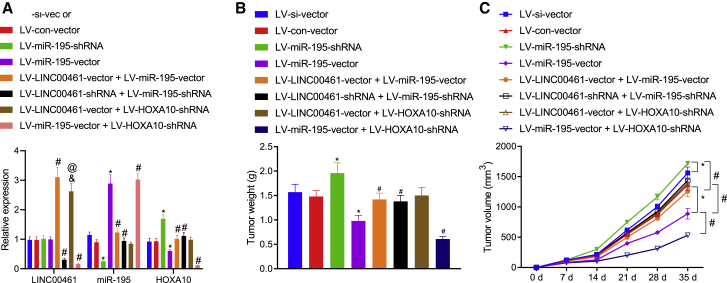
Tumorigenesis in mice is enhanced by LINC00461 by blocking miR-195-mediated inhibition of HOXA10(A) The expression of LINC00461, miR-195, and HOXA10. (B) Tumor weight in nude mice. (C) Tumor volume in nude mice. All of the data were measurement data expressed as means ± standard deviations. The data among multiple groups were compared using 1-way ANOVA or repeated-measures ANOVA. n = 7 for BALB/c-nu mice following each treatment per experimental xenograft. ∗p < 0.05 versus the LV-si-vector or LV-con-vector group. #p < 0.05 versus the LV-miR-195-shRNA or LV-miR-195-vector group. &p < 0.05 versus LV-LINC00461-vector + LV-miR-195-vector group. @p < 0.05 versus the LV-LINC00461-vector + LV-miR-195-shRNA group.